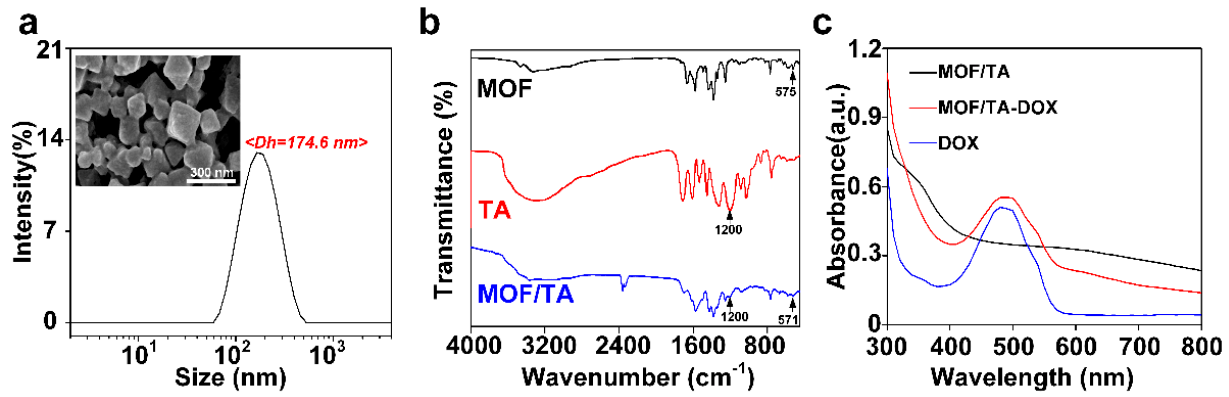
Figure 1. Preparation and synthesis of MTD: ( a ) the determination of particle size and morphology with SEM and DLS; ( b ) FTIR spectra; ( c ) UV-vis spectrum of nanoparticles.